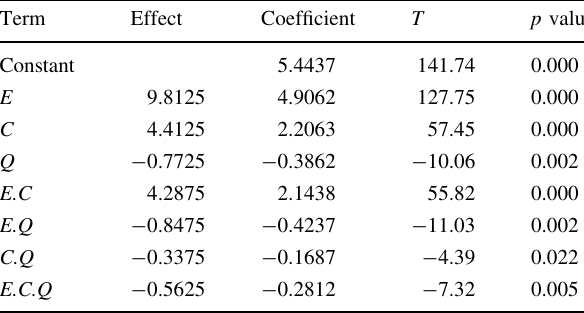
Table 6 Estimated effects and coefficients for SPC (coded units)